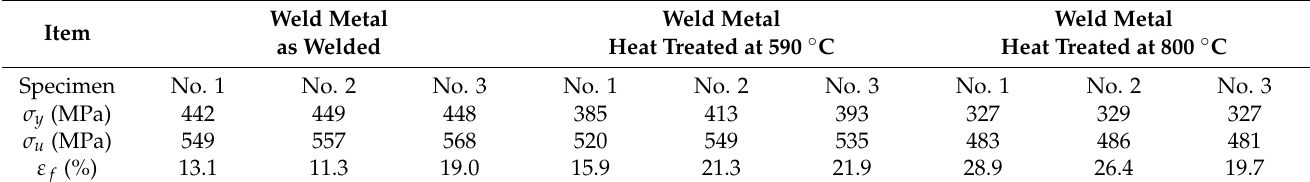
Table 3. Yield strength, tensile strength, and elongation rate of the weld metal.